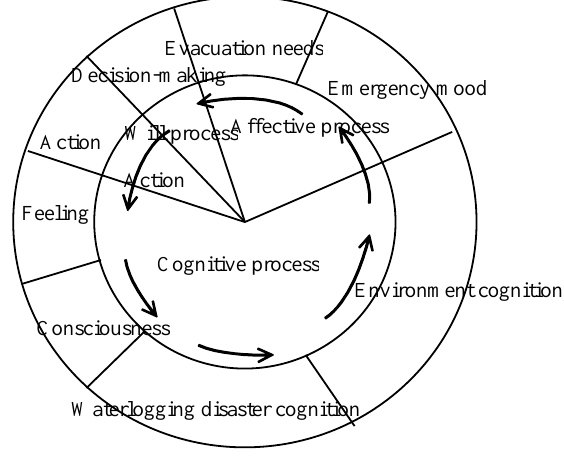
Figure 4. Diagram of the psychological process of evacuation behavior